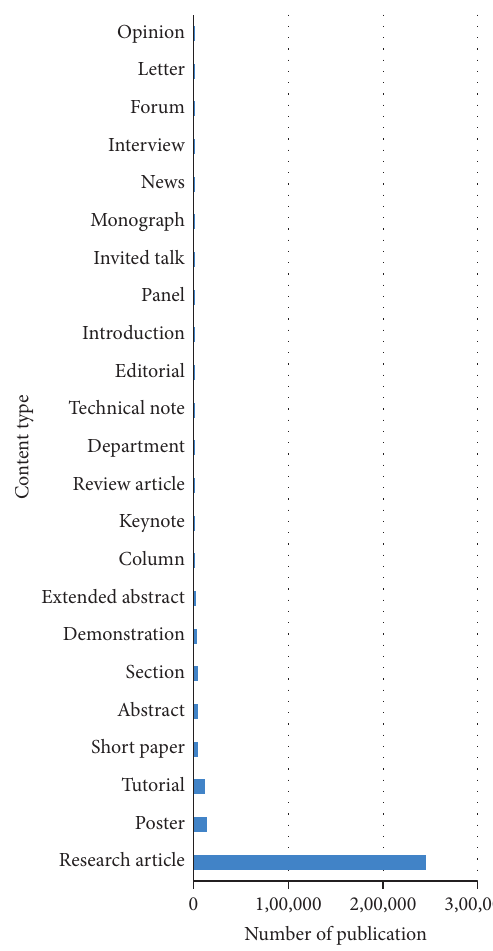
Figure 6: Content type and number of